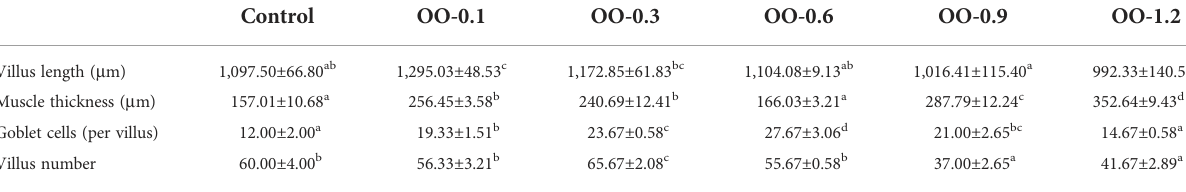
TABLE 4 Effects of dietary oregano oil on intestinal morphology of juvenile hybrid grouper.